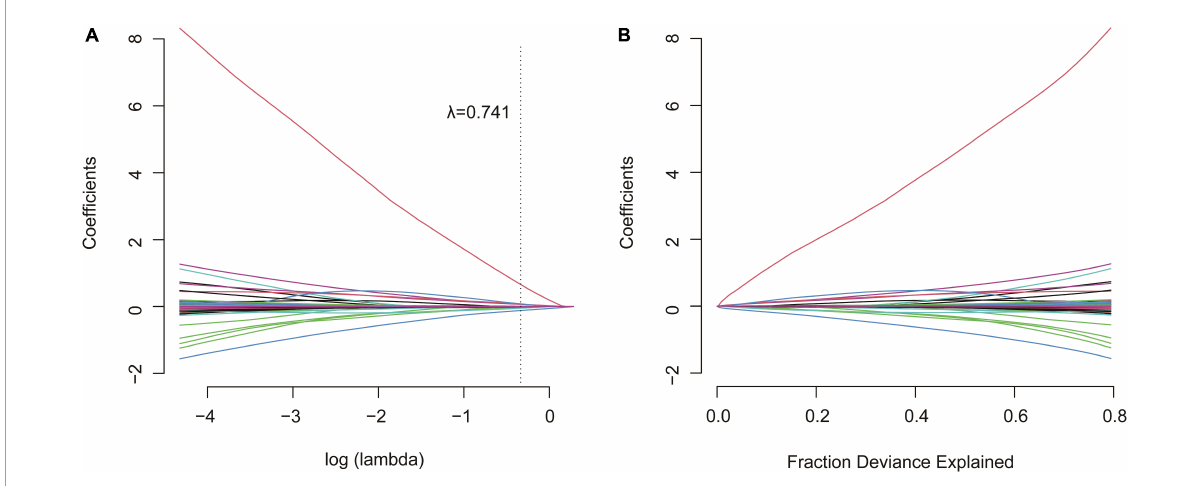
FIGURE2 Elastic net model profile plots. (A) Coefficient profile plots showing how size of the coefficients of baseline, preoperative and intraoperative factors shrinks with increasing value of the λ penalty. Factors and their regression coefficients could be selected for the model when it attained to the optimal combination of α and λ for the elastic net model. Each curve represented one factors and there were 13 factors were obtained when the value of λ was 0.741. (B) The size of coefficients of preoperative and intraoperative factors increases with increasing value of the fraction deviance explained. The range of fraction deviance for the variation of the value of λ with variable selection was showed in the elastic net model.